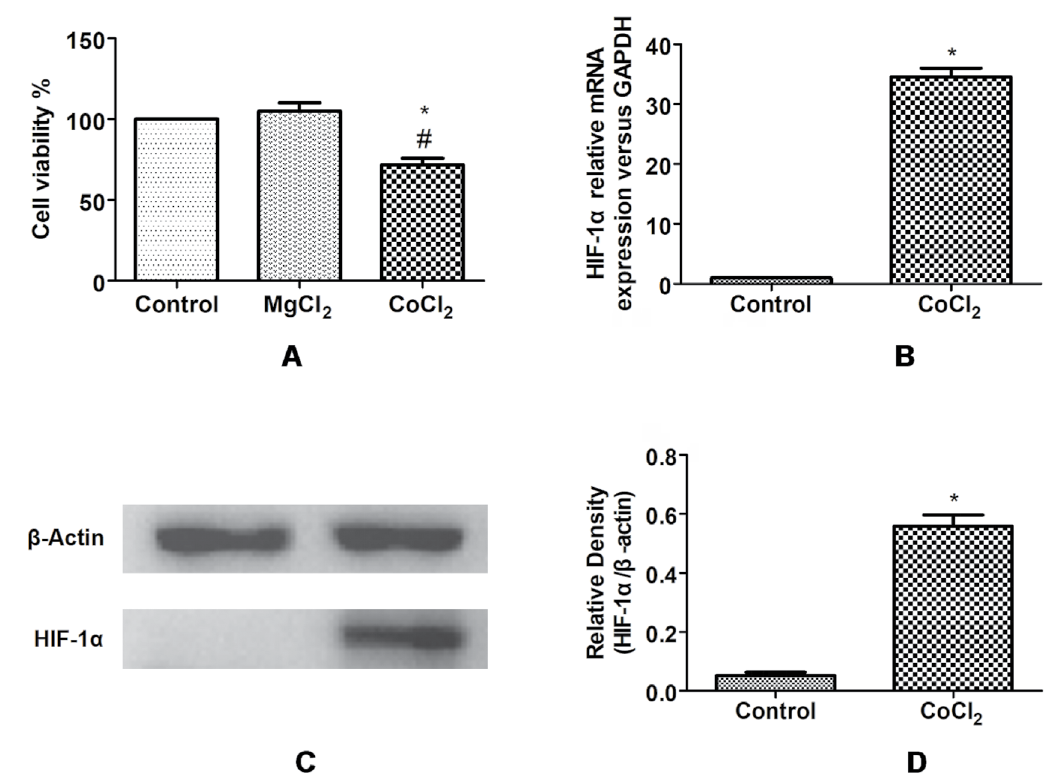
. (A) CCK-8 assay to detect the effect of CoCl 2 group, Newman-Keuls multiple comparisons test. (B) qPCR was used to determine the 2 ; *P<0.05 vs. the blank control group, T-test. (C) WB method to detect the 2 (D) *P<0.05 vs. the blank control group, 2.